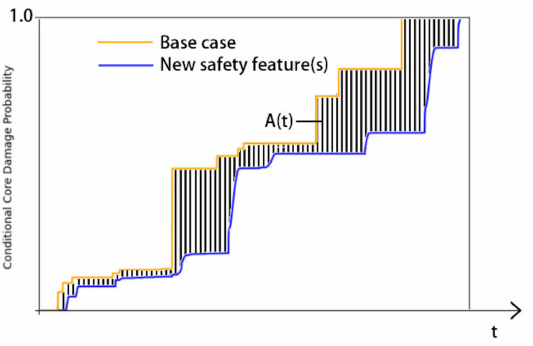
Figure 6. CDF-based sensitivity indicator calculations (Benefit index).